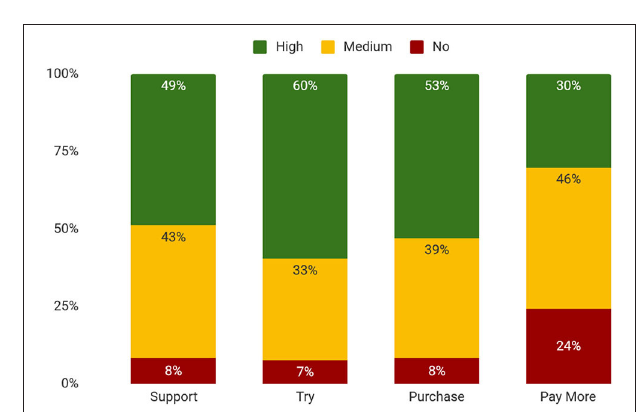
FIGURE 3 | Current familiarity with cultivated meat in the general population and by generations.